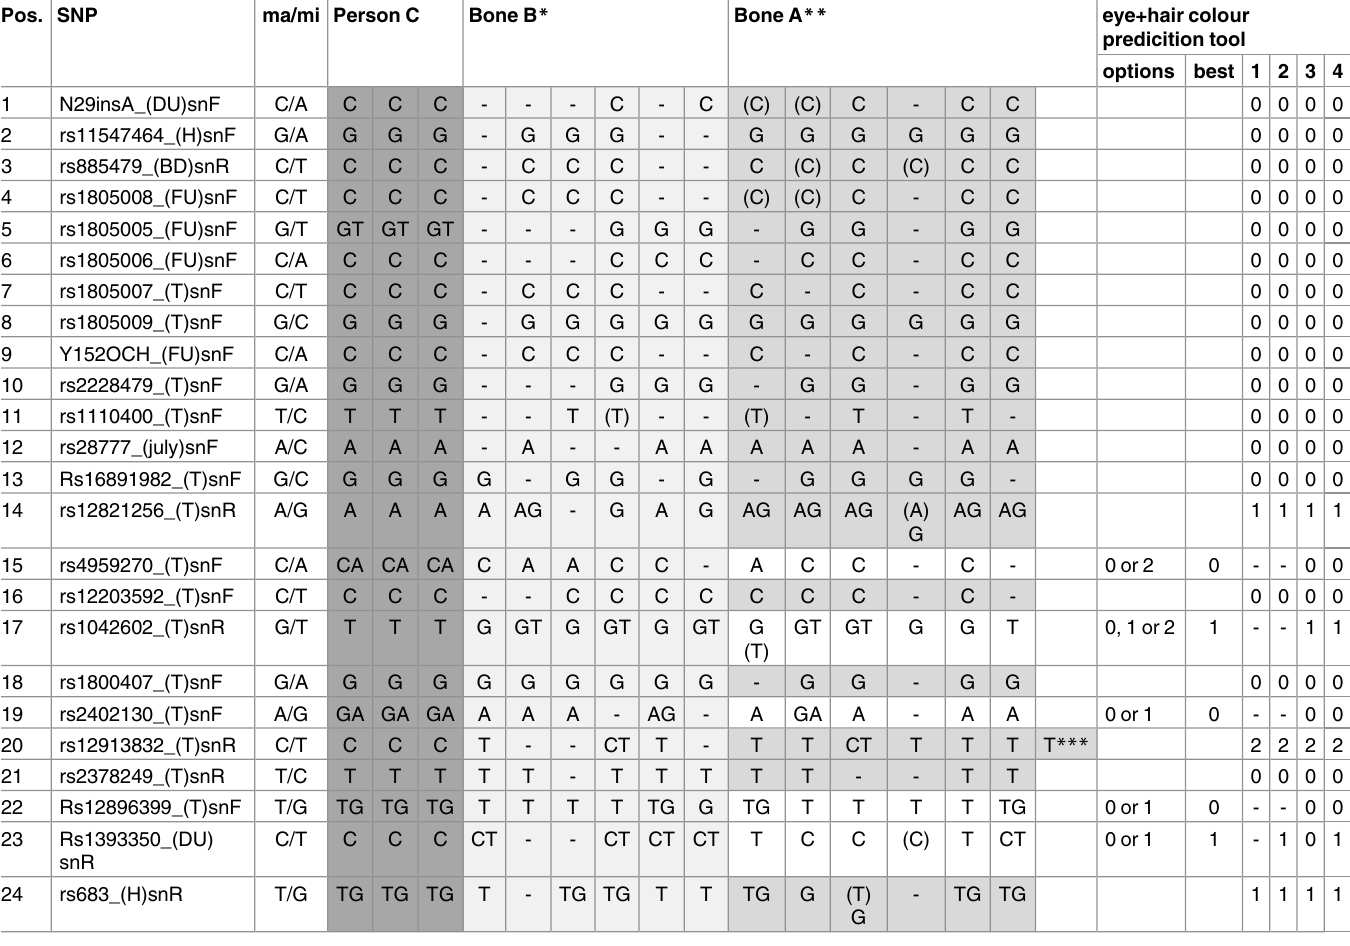
Table 1. Hair and eye colour analysis based on the HIrisPlex system, results from bone samples A and B, and person C. Pos.